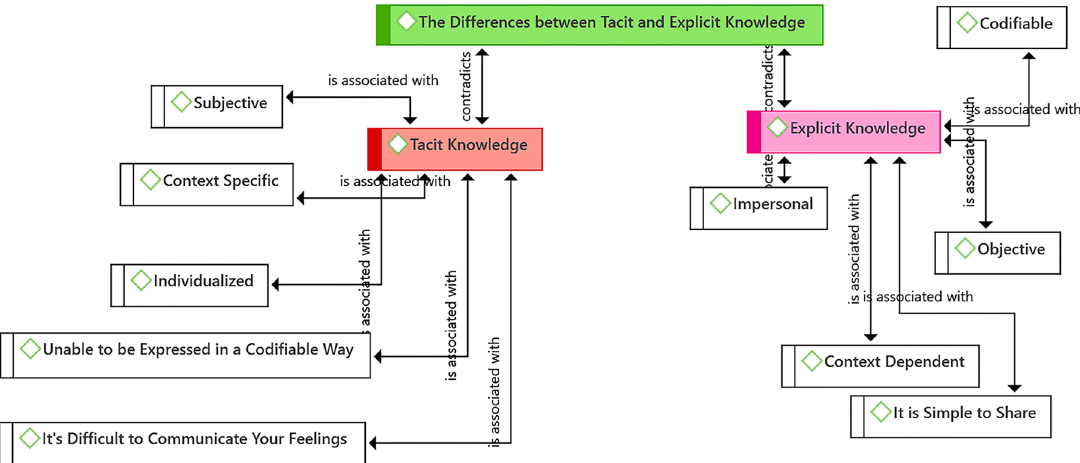
Figure 6. The Differences between Tacit and Explicit